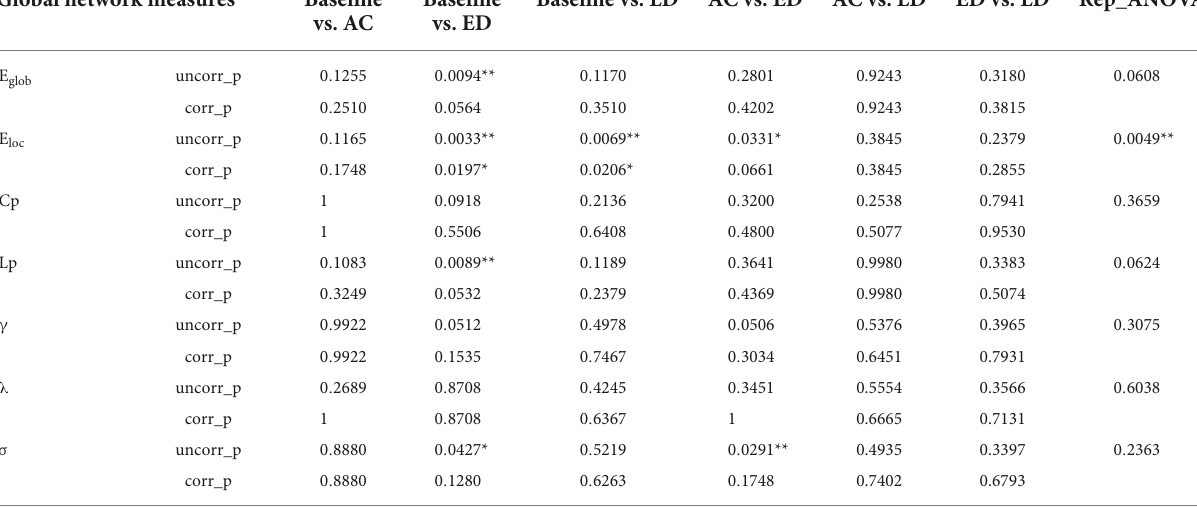
The statistical results with p -values of the global network measures of 35 patients for four groups (the baseline, post-RT-AC, post-RT-ED, and post-RT-LD). E glob , global efficiency; E loc , local efficiency; Cp, cluster coefficient; Lp, shortest path length; γ , normalized cluster coefficient; λ , normalized characteristic path length; σ , small-worldness; uncorr_p, uncorrected p -value; corr_ p, corrected p -value with the false discovery rate (FDR) correction; Rep_ANOVA, one-way repeated measures analysis of variance; AC, post-RT-AC; ED, post-RT-ED; LD, post-RT-LD;* p < 0.05;** p < 0.01.